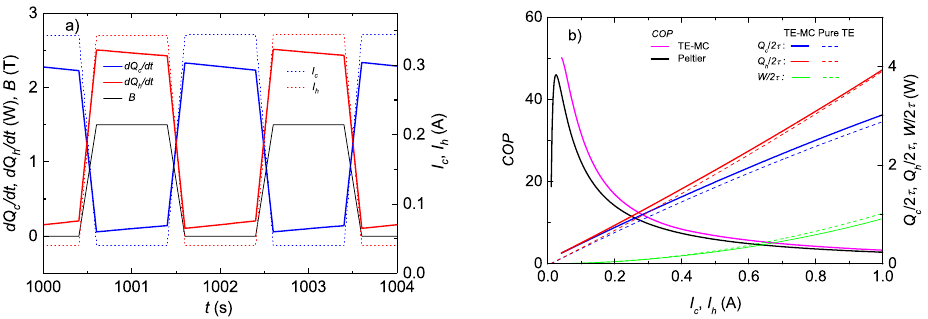
Figure 8. ( a ): Instantaneous heat power extracted from the cold source, ˙ Q c , and released to the hot sink, ˙ Q h , and magnetic field, B , for a few periods. Instantaneous currents, I c ( t ) and I h ( t ) , through the cold and hot Peltier cells, respectively. ( b ): COP of the TE-MC sandwich and for a pure Peltier heat transfer, for increasing amplitude of I c and I h . Heat power extracted from the cold source, Q c /2 τ , released to the hot sink, Q h /2 τ , and work power, W /2 τ = ( Q h − Q c ) /2 τ . The heat and work powers are averaged over one